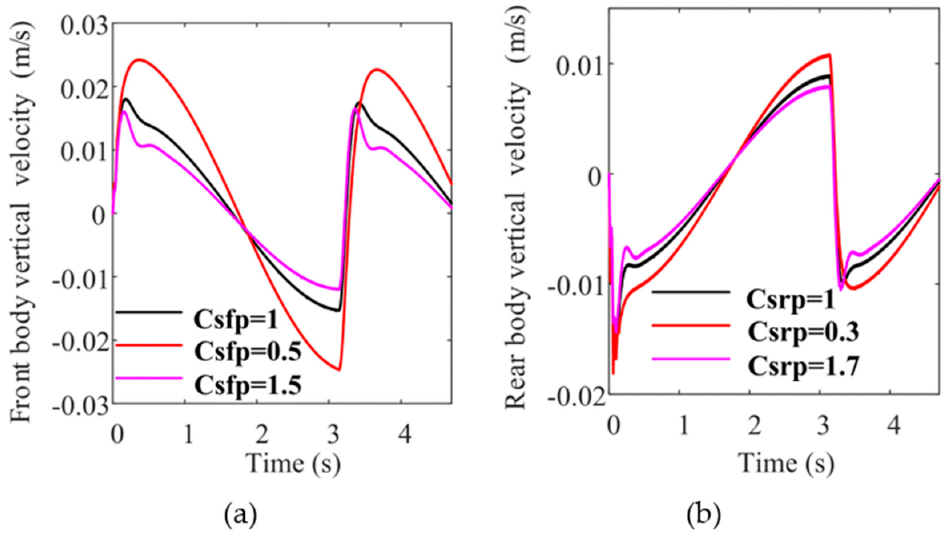
Figure 7. Suspension damping mismatch effect. ( a ) Front suspension damping mismatch effect; ( b ) Rear suspension damping mismatch effect.